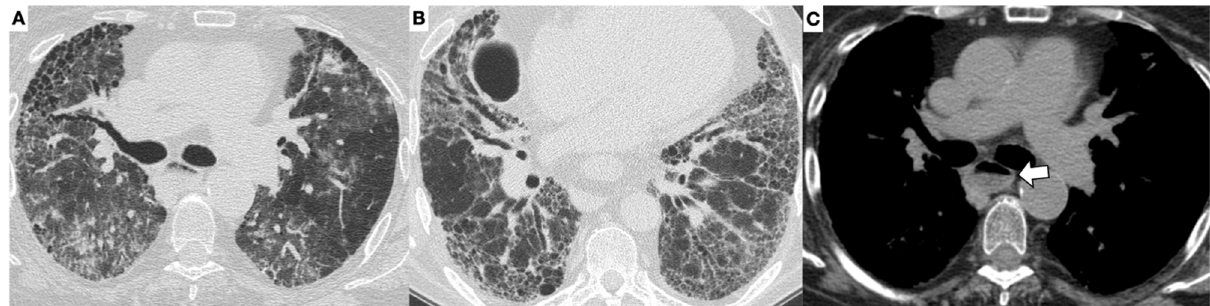
Figure 3. UIP pattern in a patient with systemic sclerosis. On the axial HRCT images at different levels ( A,B ), there are bilateral reticular opacities with inter- and intralobular septal thickening, more prevalent in the peripheral regions of the lungs, traction bronchiectasis, ground-glass opacities, and honeycombing. On the axial image in the mediastinal window ( C ), the dilated esophagus, with an air-fluid level within the lumen, can be well appreciated (arrow).